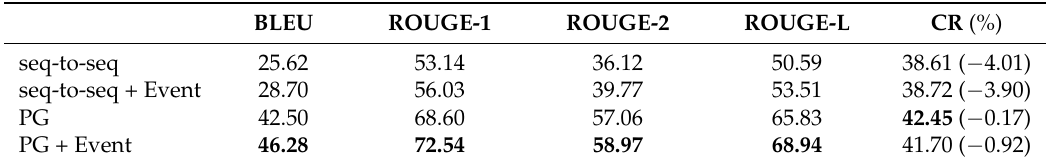
Table 4. Experimental results on Filippova